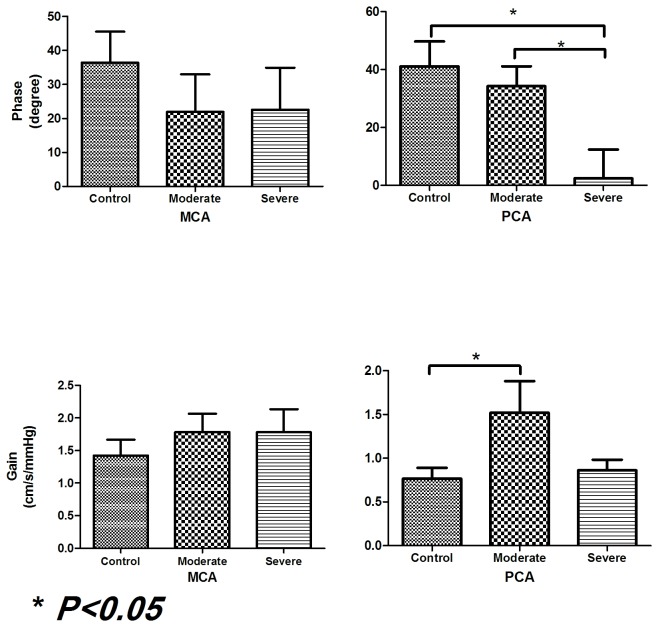
Statistical analysis (ANVOA) of phase shifts and gains in MCA and PCA.For MCA, gains are elevated and phase shifts are reduced when BA stenosis is either moderate or severe. However, these changes are not statistically significant. For PCA, it shows that the reduction of phase shift is proportional to the occlusion, whereas the gain for PCA is increased significantly for moderate stenosis and decreased for severe stenosis in BA.